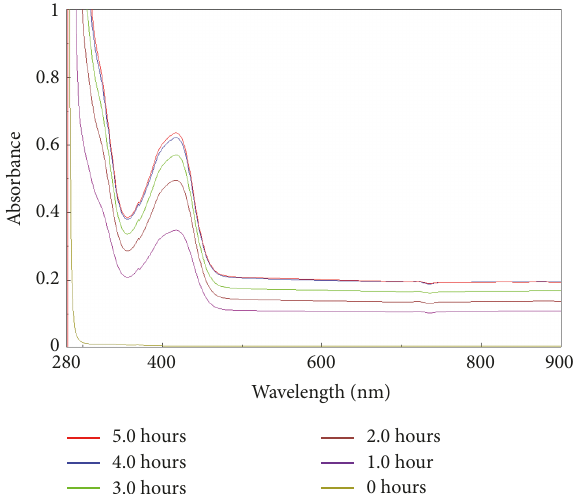
Figure 7: Absorbance curves of potassium ferricyanide measured in the solution at different diffusion times. Initially, 1% potassium ferricyanide was used as the diffusion solution in the donor cell.